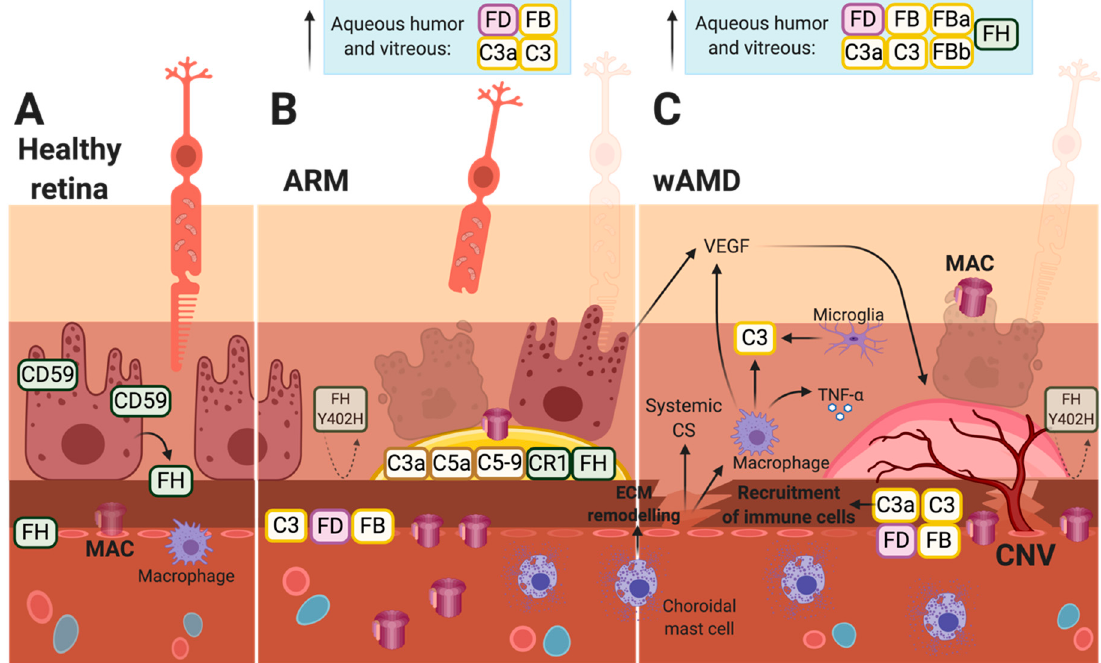
Figure 4. Patient samples reveal increased complement deposition in ARM and AMD eyes. ( A ) The human retina is protected from the complement system by Factor H and CD59, and potential inflammatory immune cells are localized on the choroidal side of the outer blood–retina barrier (BRB). ( B , C ) Complement components are deposited in different compartments of the eyes in both ARM and wAMD patients. Loyet et al. found the highest level of complement deposition in the CC followed by Bruch’s membrane [52]. The RPE, macrophages, and complement system are involved in the production of vascular endothelial growth factor (VEGF) and, thus, the formation of CNV. AP, alternative pathway. ARM, age-related maculopathy. BRB, blood–retina barrier. CC, choriocapillaris. CNV, choroidal neovascularization. CP, classical pathway. ECM, extracellular matrix. FB, Factor B. FD, Factor D. FH, Factor H. FI, Factor I. LP, lectin pathway. MAC, membrane-attack complex. PR, photoreceptor. RPE, retinal pigment epithelium. TNF- α , tumor necrosis factor-alpha. VEGF, vascular endothelial growth